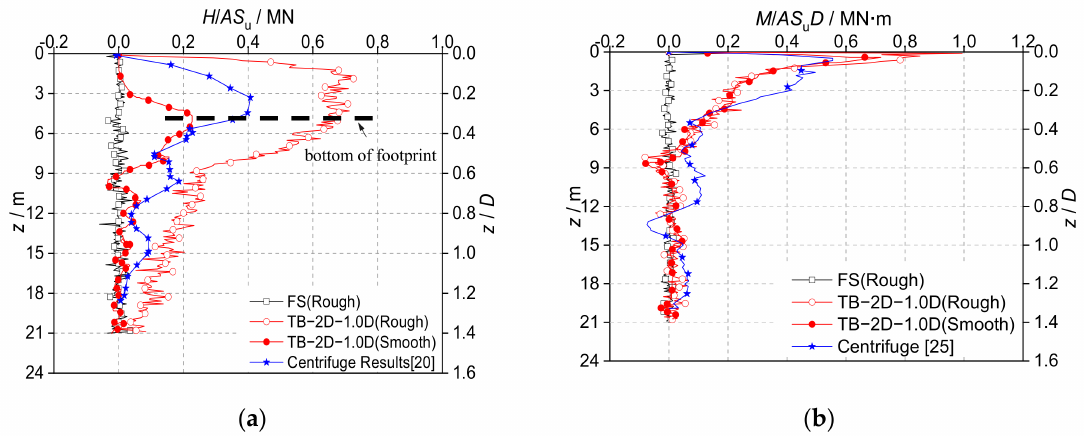
Figure 7. E ff ect of existing footprint on the V , H , and M responses of the flat base